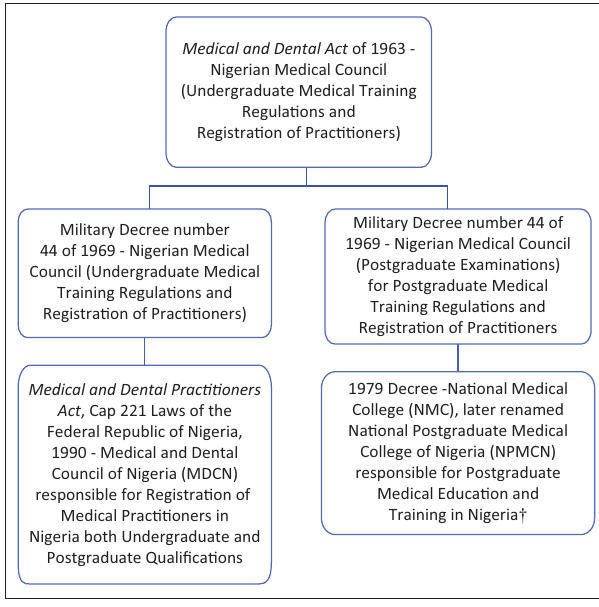
FIGURE 1: Evolution of postgraduate medical training in Nigeria of which psychiatry is a